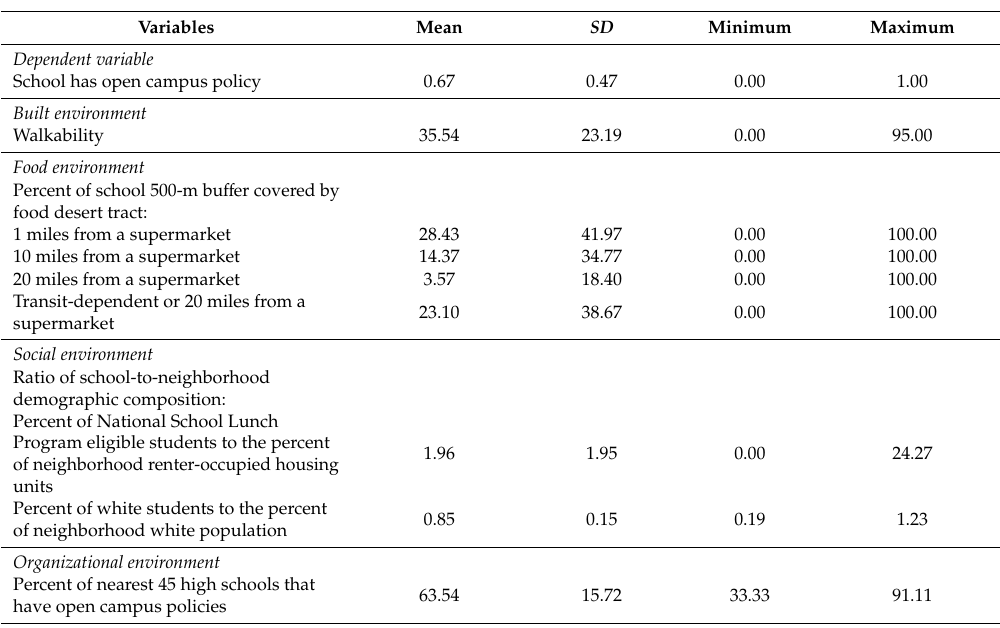
Table 1. Descriptive statistics for independent variables used in the logistic regression analysis ( n = 200 public high